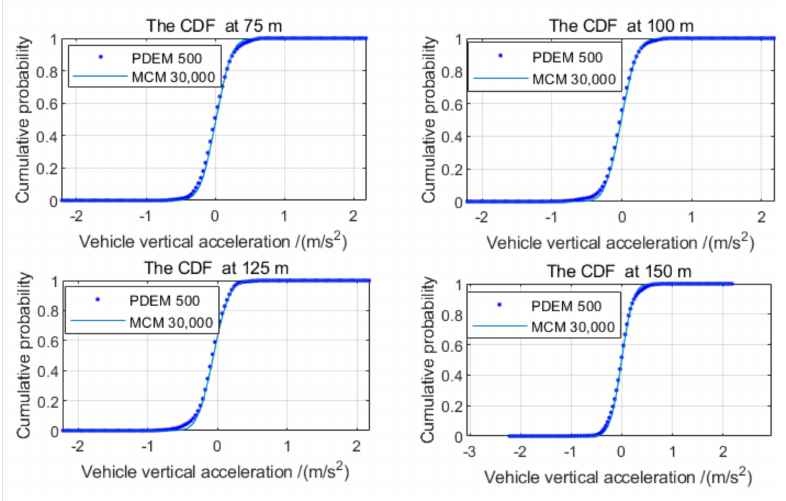
Figure 7. CDF comparison of the car coaxial accelerations at different